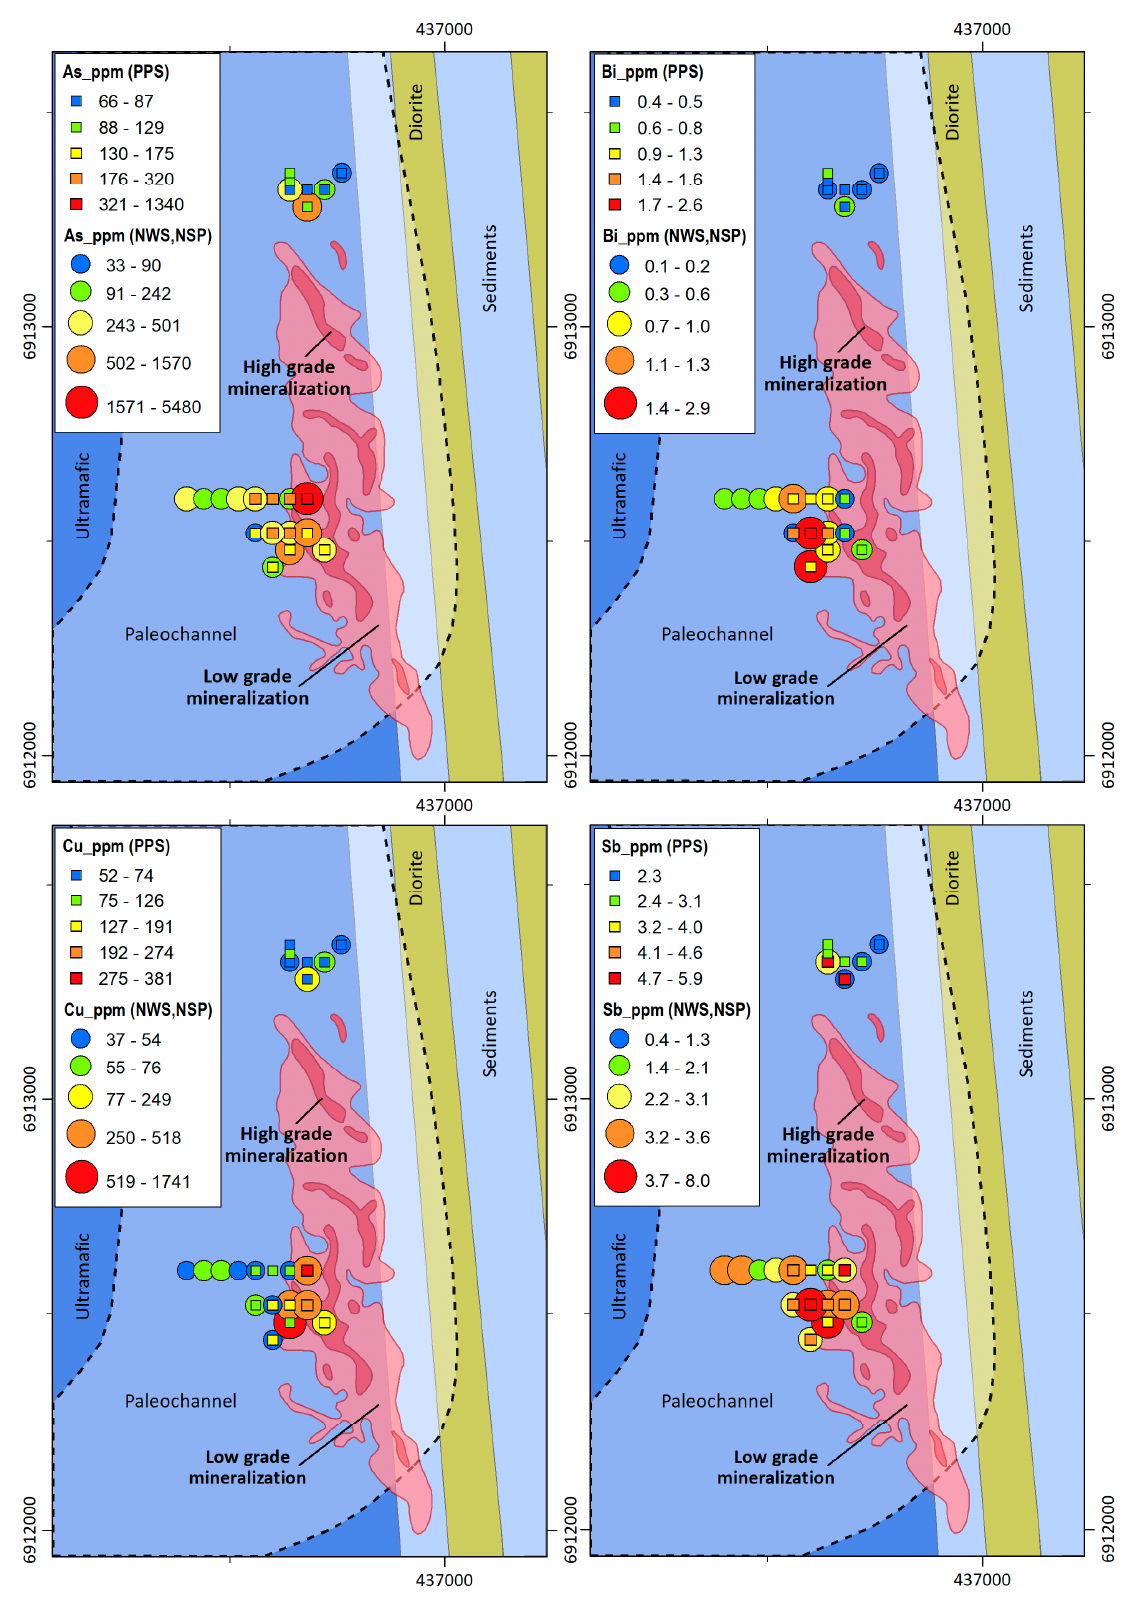
Figure 13. As, Bi, Cu and Sb concentrations in the PPS, NWS and NSP locating the buried mineralization. Due to a very few samples of NSP, NWS and NSP are combined.